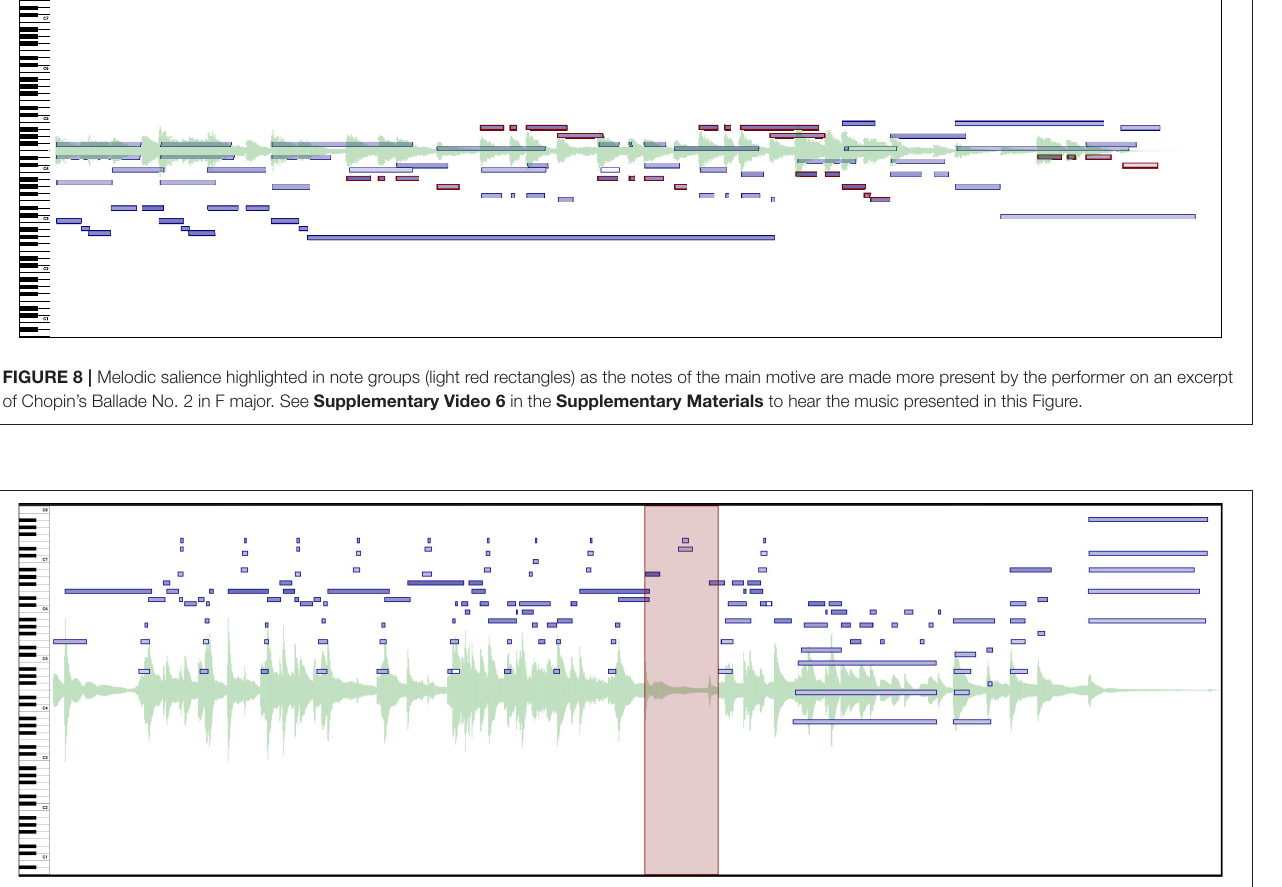
FIGURE 9 | A tipping point marked with a region (light red rectangle) on Grieg’s Solveig’s Song evidences how a musical moment is stretched to its limit. See Supplementary Video 7 in the Supplementary Materials to hear the music presented in this Figure.